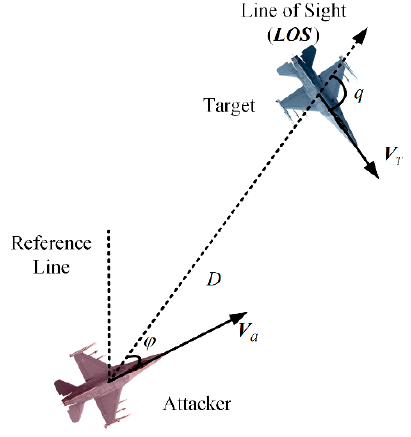
Figure 1. The relative situation of an attacker and a target.